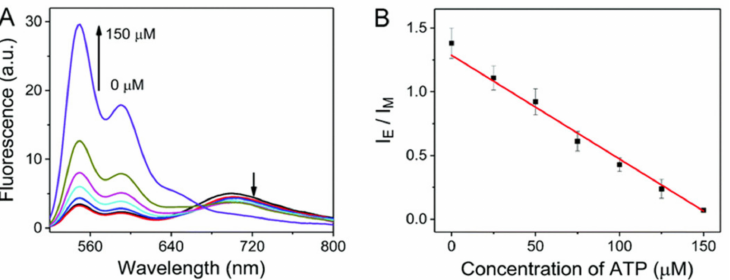
Figure 30. ( A ) Fluorescence spectra of probe 10@ZIF-8 with the addition of ATP (0–150 µ M) in cell lysates (5%). ( B ) Corresponding F excimer / F monomer (I E /I M ) value based calibration curve for ATP (0–150 µ M) in cell lysates (5%)